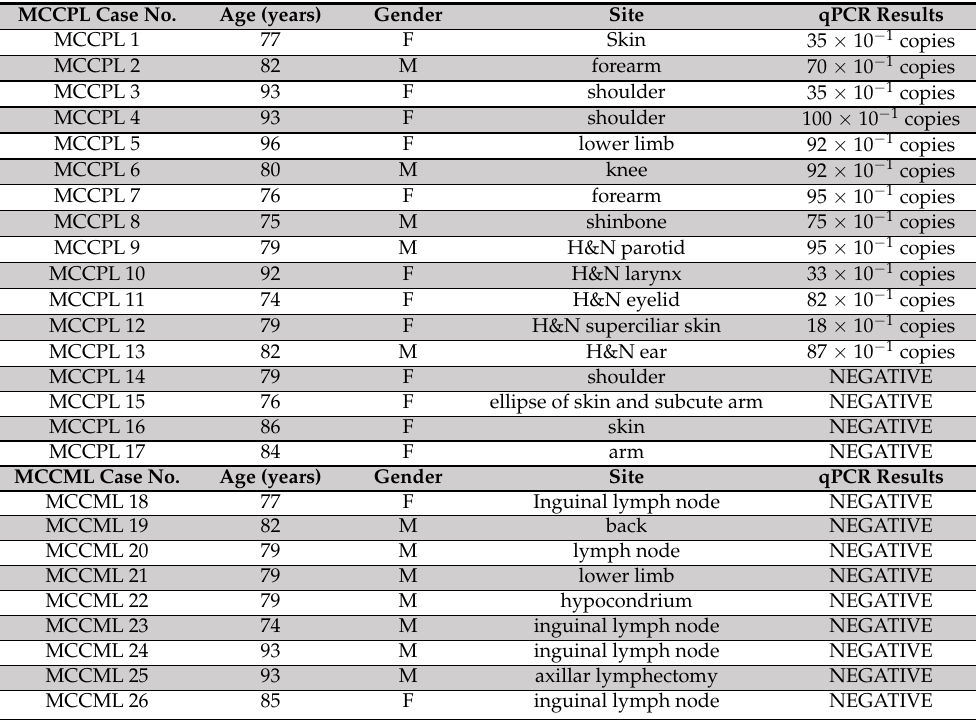
MCCPL: primary lesions; MCCML: metastatic lesions; qPCR: quantitative polymerase chain reaction; H&N: head and neck. Modifications in VP1 and NCCR sequencing with relative genotype were reported